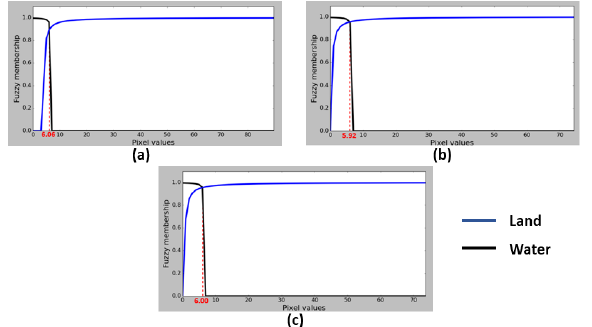
Figure 8. Membership of land and water, calculating the threshold with centroid defuzzification. (a) Using Mean-Shift segmentation results, (b) Using Random Forest segmentation results, (c) Using Whale Optimization segmentation results